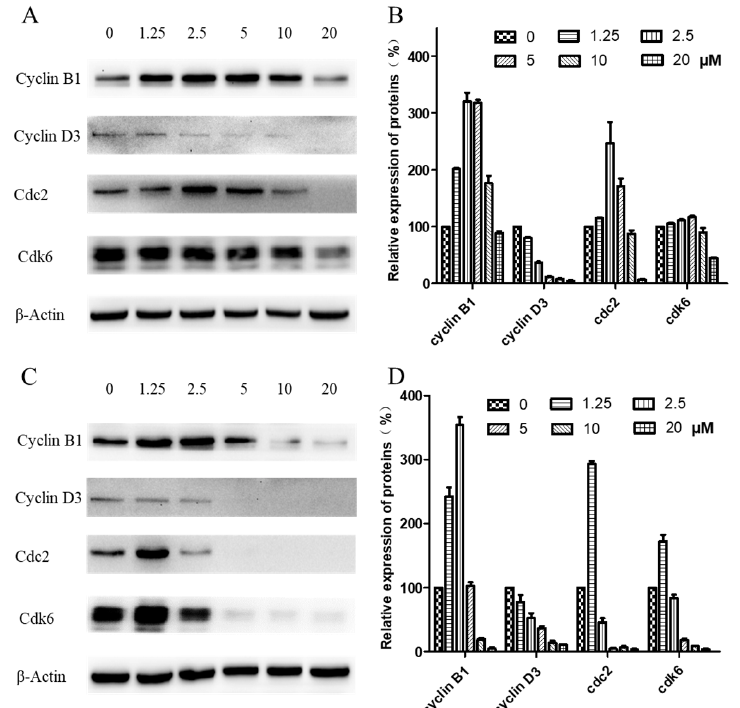
Figure 6. Effects of arnicolide D on the expression of key cell cycle proteins. CNE-2 cells were treated with arnicolide D at concentrations of 1.25–20 µ M for 24 h or 48 h, and cell lysates were harvested and subjected to Western blot analysis using antibodies against cyclin B1, cyclin D3, cdc2, and cdk6. β -actin was used as an internal control. Western blot results are shown for ( A ) 24 h or ( C ) 48 h treatments. Bar graphs ( B , D ) showing the quantified relative expression of the proteins. Data are expressed as means ± SD.